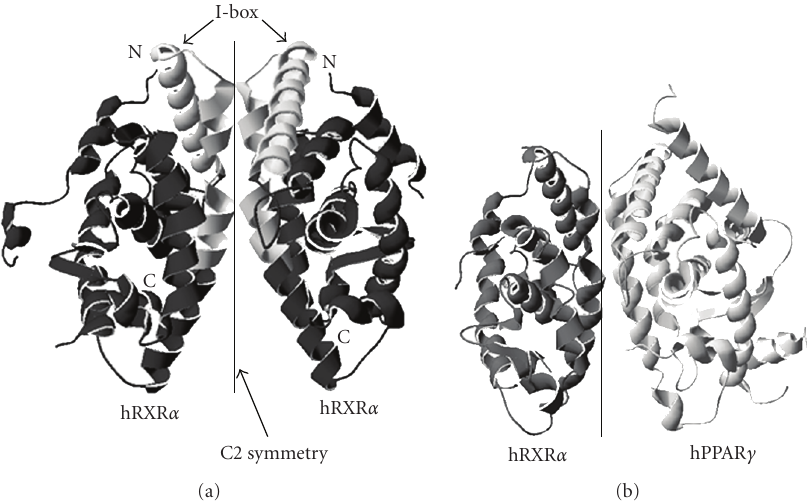
Figure 2: (a) Ribbon drawing of the human RXR α LBD homodimer (PBD 1MZN). The RXR monomers are colored in black. The N and C termini are labeled “N” and “C”, respectively. Rotation of 180 ◦ on the Z-axis of the homodimer results in a geometry equivalent of the starting geometry (i.e., C2 symmetry). The I-boxes are colored in light grey. (b) Ribbon drawing of the hRXR α /hPPAR γ LBD heterodimers (PDB 3E00, also see Figure 1). The RXR and PPAR monomers are colored in dark and light grey,